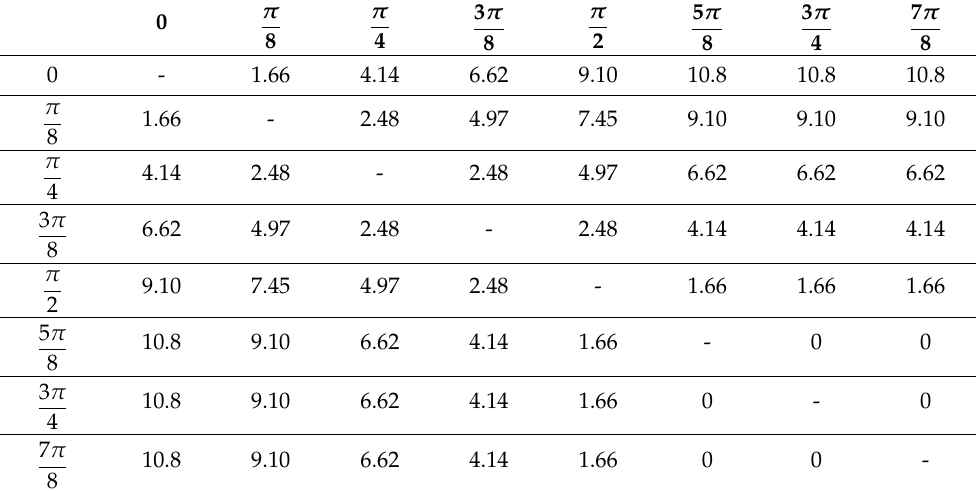
Table 9. Time difference in Hours at peak magnification between microlensing photometric curve with Φ shown in the first row, compared to the photometric curve with Φ in the first column. Error values for R = 42,000 km.